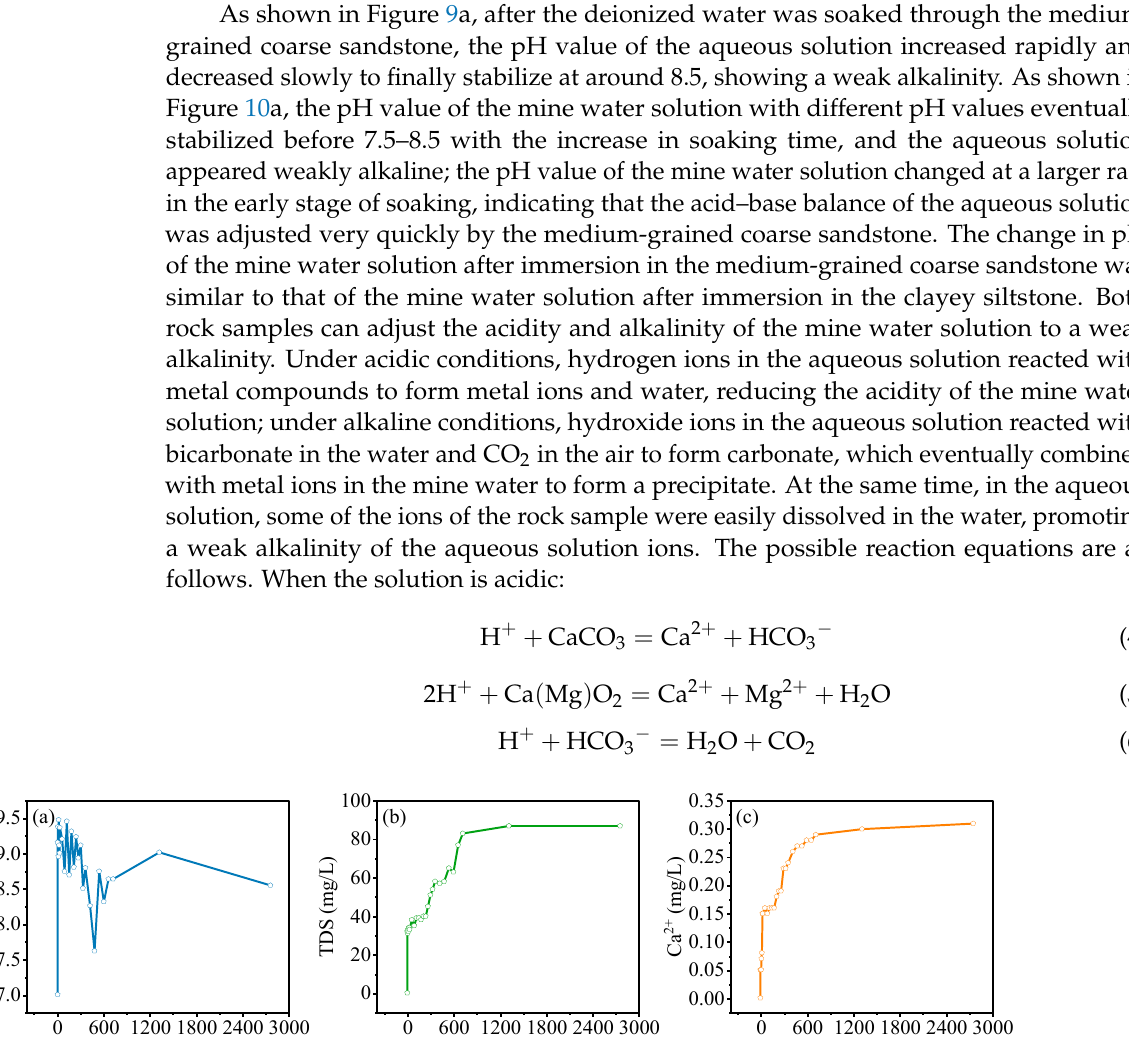
Figure 10. Medium-grained coarse sandstone soaked by mine water at different pH values: ( a ) pH value; ( b ) TDS concentration; ( c ) Ca 2+ concentration. 3.5. Adsorption Characteristics of Dynamic Leaching of Gangue Figures 11a and 12a show that the pH of the dewatering solution of the muddy siltstone and medium-grained coarse sandstone changed rapidly and eventually stabilized after de- watering with mine water of different pH values. The pH values of the dewatering solution of the muddy siltstone were stabilized at 6.25, 6.5, 8.2, and 8.5 after dewatering with mine water with pH values ranging from 4 to 10. The pH values of the dewatering solution of the medium-grained coarse sandstone were stabilized at 5.6, 6.8, 8.2, and 9.5 after dewatering with mine water with pH values ranging from 4 to 10. The pH values of the leachate were stabilized at 5.6, 6.8, 8.2, and 9.5; the rock samples were adjusted toward a weak base by depleting the solution of the hydrogen or hydroxide ions. In the dynamic leaching experi- ments, the contact time between the rock sample and solution was not as long as it was in the static leaching experiments, and the change in pH was less than under static leaching. After the muddy siltstone and medium-grained coarse sandstone were leached by mine water solutions of different pH values, the TDS values of the leached solution de- creased at 0–20 min and increased at 20–30 min, and finally stabilized, with the stabilized value being less than the initial one when pH=4,8,10, as shown in Figures 11b and 12b. How- ever, when pH=6, the TDS value of the solution showed different characteristics, decreasing at 0–20 min, then increasing to the initial value at 60 min, and decreasing to the initial value after 90 min. When the mine water solution was acidic or alkaline, the TDS value of the dripping fluid decreased more, and when the mine water solution was neutral, the TDS value of the dripping fluid decreased less. The leachate led to dissolution of the rock sample surface, increased void space, and enhanced adsorption. The TDS value of the leaching so- lution decreased gradually due to ion precipitation and adsorption in the mine water. The following chemical equations may be present in the solution. As shown in Figures 11c and 12c, the calcium ion concentrations in the dewatering so- lution decreased rapidly and eventually stabilized after the leaching of mine water at differ- ent pH values. During acidic mine water leaching, the calcium ion concentration first